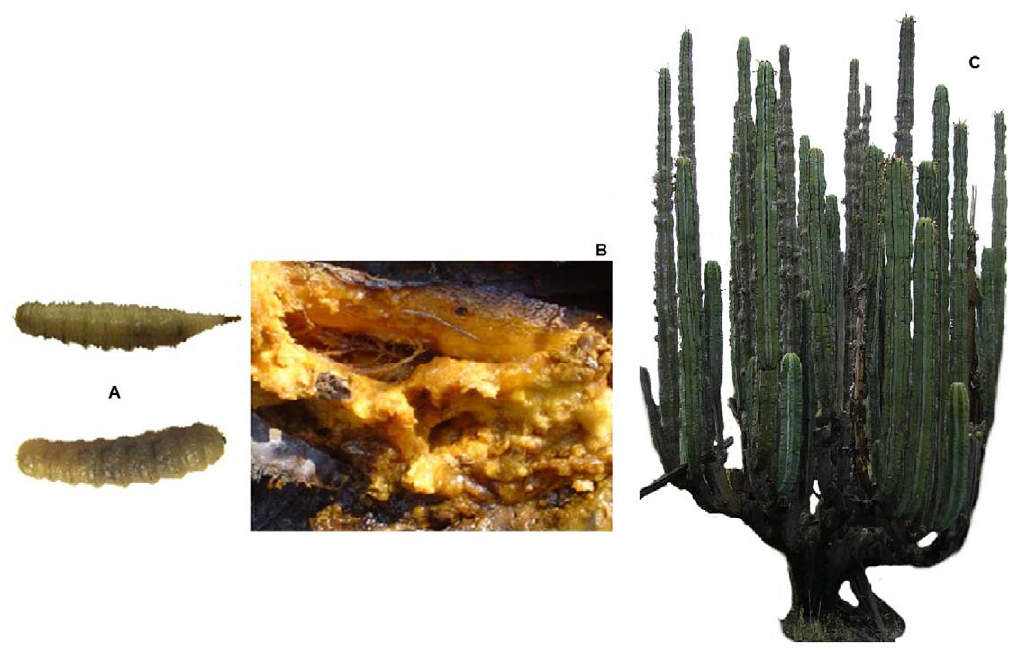
Figure 1. Larval species (a), decayed cactus tissues (b) and columnar cactus Isolatocereusdumortieri (c).